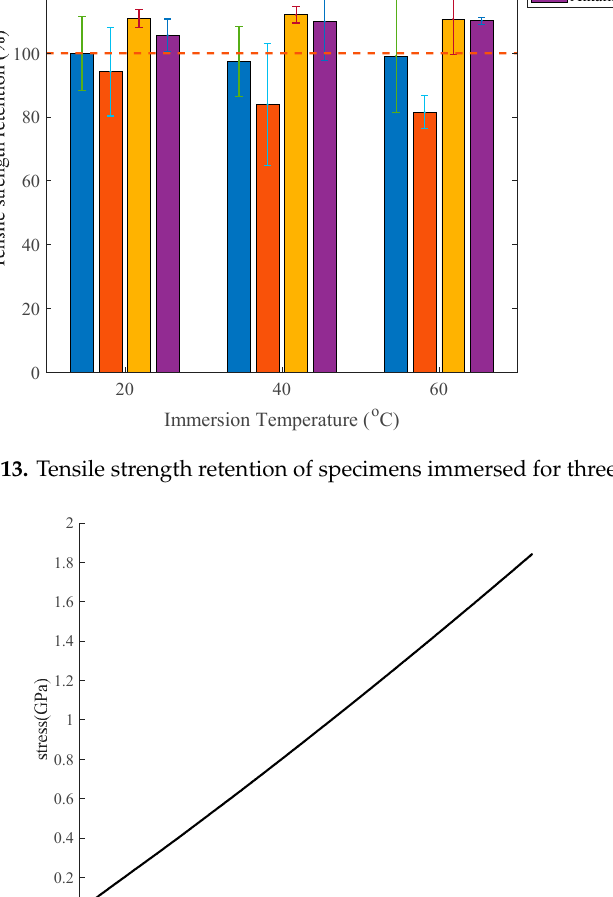
Figure 14. Tensile stress / strain relationship of naked CFRP plate immersed in alkaline solution for 90 days. Table 4. Fracture strain of naked immersed specimens.